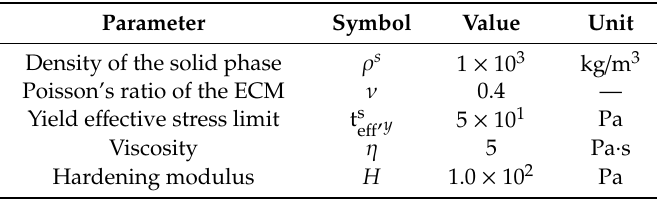
Table 3. Parameters for ECM with porosity